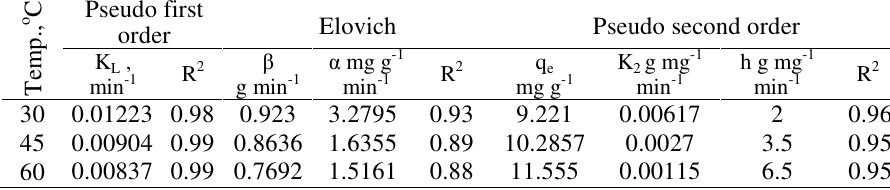
Figure 3c. Pseudo second order plot - temperature variation Table 2. Rate parameters for the adsorption of Reactive Red 2 onto Pongamia pinnata seed shell waste activated carbon at various